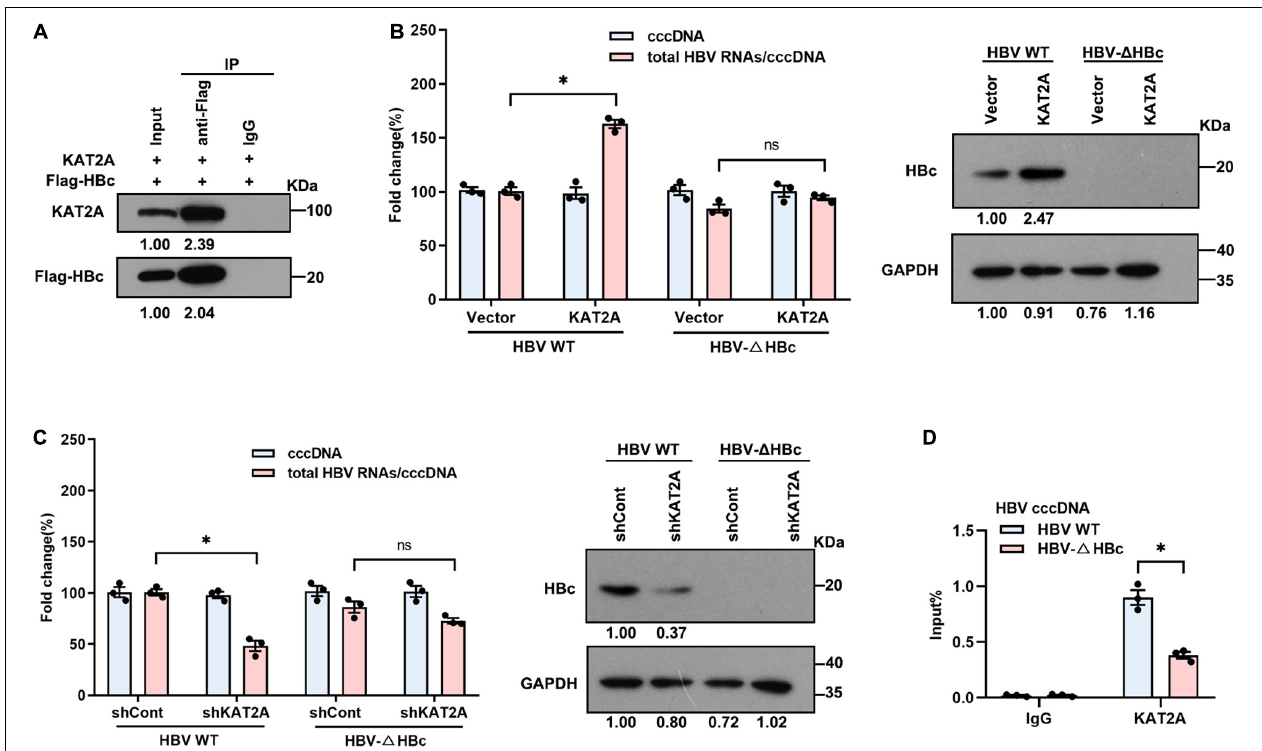
FIGURE 5 | KAT2A binds to the cccDNA minichromosome through interaction with HBc. (A) HepG2-NTCP cells were co-transfected with plasmids encoding KAT2A and Flag-HBc for 3 days, the cells were subjected to Co-IP assay with the indicated antibody. The expression of the indicated proteins was analysed by western blot. (B,C) HepG2-NTCP cells were transduced with lentivirus expressing KAT2A or shKAT2A for 24 h, then infected with HBV wild type virus (HBV WT virus) and HBc-deficient virus (HBV- (cid:49) HBc virus) for 4 days. Total HBV RNAs and cccDNA were extracted and quantified by real-time PCR and Taq-man probe qPCR for calculating the ratio of total HBV RNAs to cccDNA. The HBc proteins were detected by immunoblotting analysis. (D) HepG2-NTCP cells in 100 mm dishes were infected by HBV WT virus and HBV- (cid:49) HBc virus. The cells were used for ChIP assays with the anti-KAT2A antibody. * P <